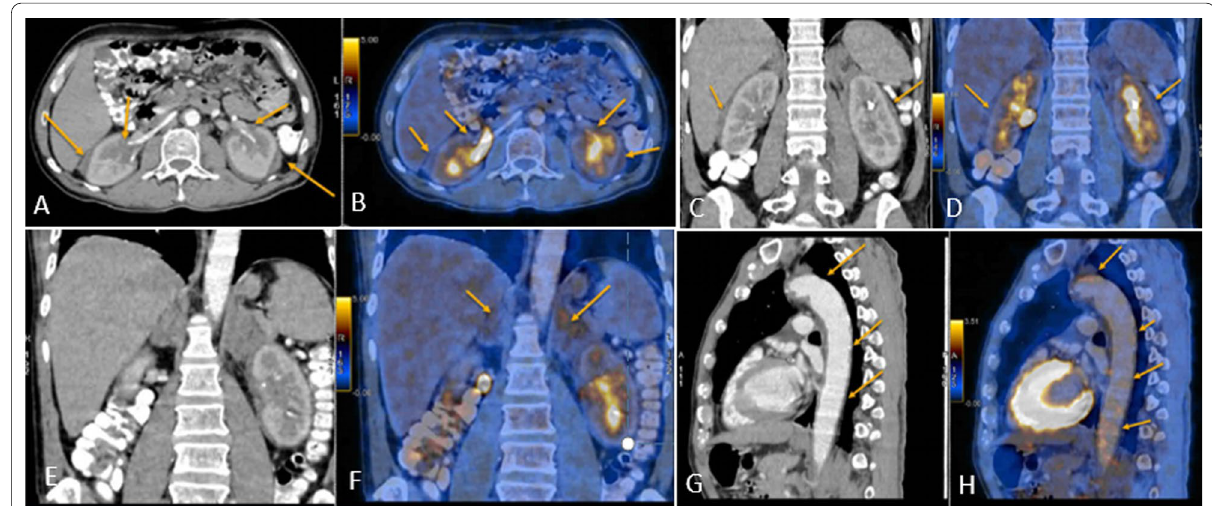
Fig. 4 Positron emission tomography scan of a 60-year-old male patient diagnosed with Erdheim–Chester disease reveals a perinephric rim of soft tissue thickening extending in bilateral renal sinuses bilaterally ( A , C ), and corresponding uptake images reveal minimal FDG activity (SUV max. 3.3) in this region ( B , D ). Both adrenal glands appear bulky ( E ) and show mild diffuse increased FDG activity (SUV max. 3.8) ( F ). Soft tissue thickening is seen along aorta ( G ) which demonstrates mildly FDG avid (SUV max. 3.4) wall uptake ( H )